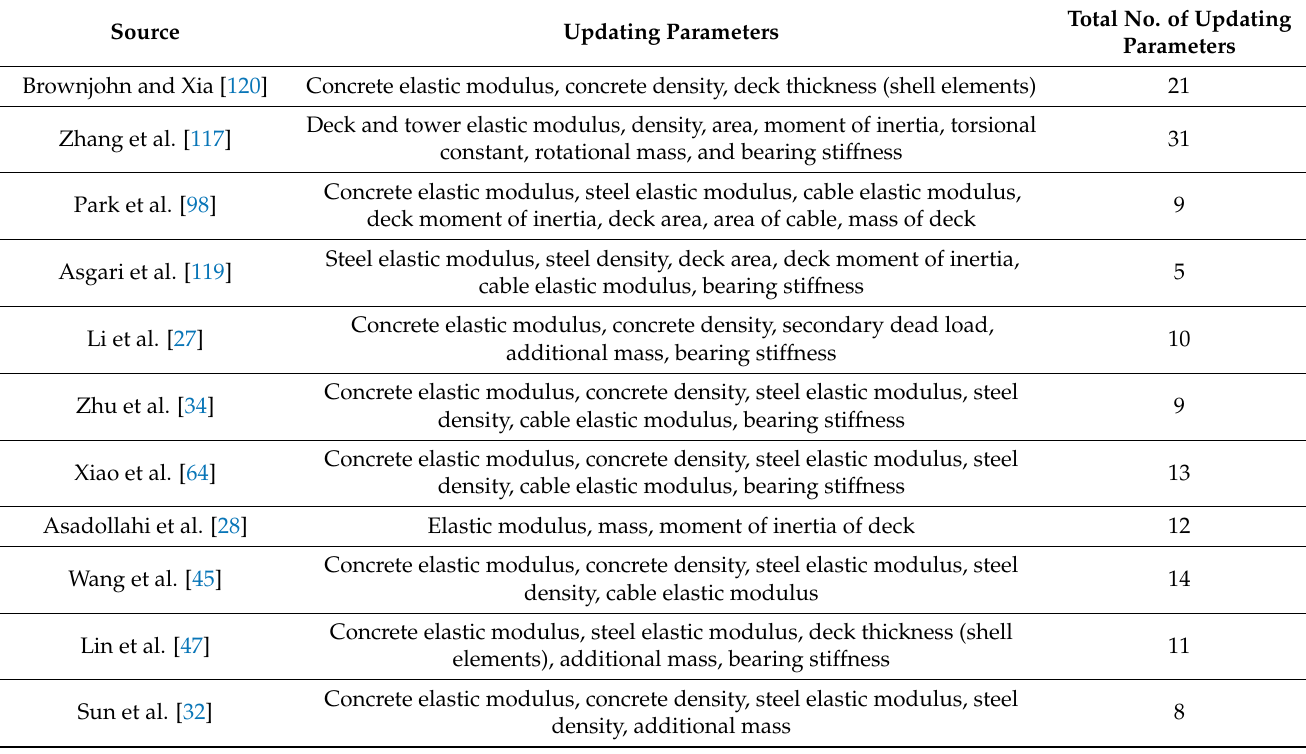
Table 5. Updating parameters used in cable-stayed bridge model updating